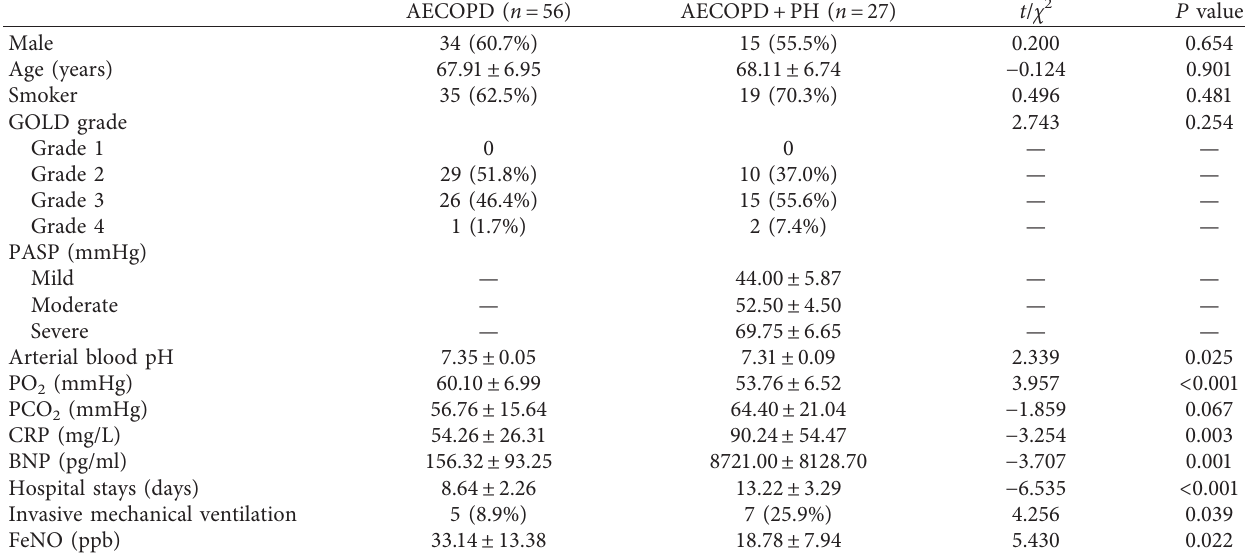
Table 1: Baseline